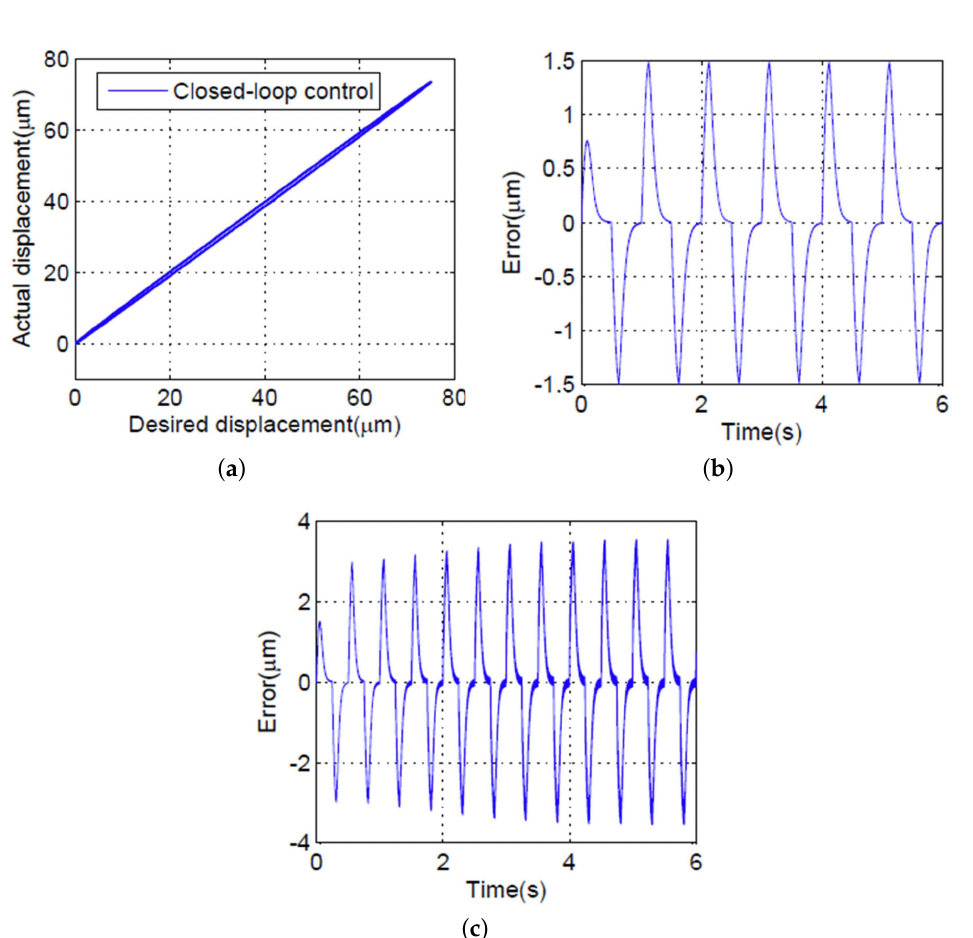
Figure 8. Experimental results with the feedforward hysteresis compensator and the PID controller. ( a ) The relationship between desired and actual displacement of the PEA under a 1 Hz sinusoidal input. ( b ) Tracking error in the case of a 1 Hz input signal. ( c ) Tracking error in the case of a 2 Hz input